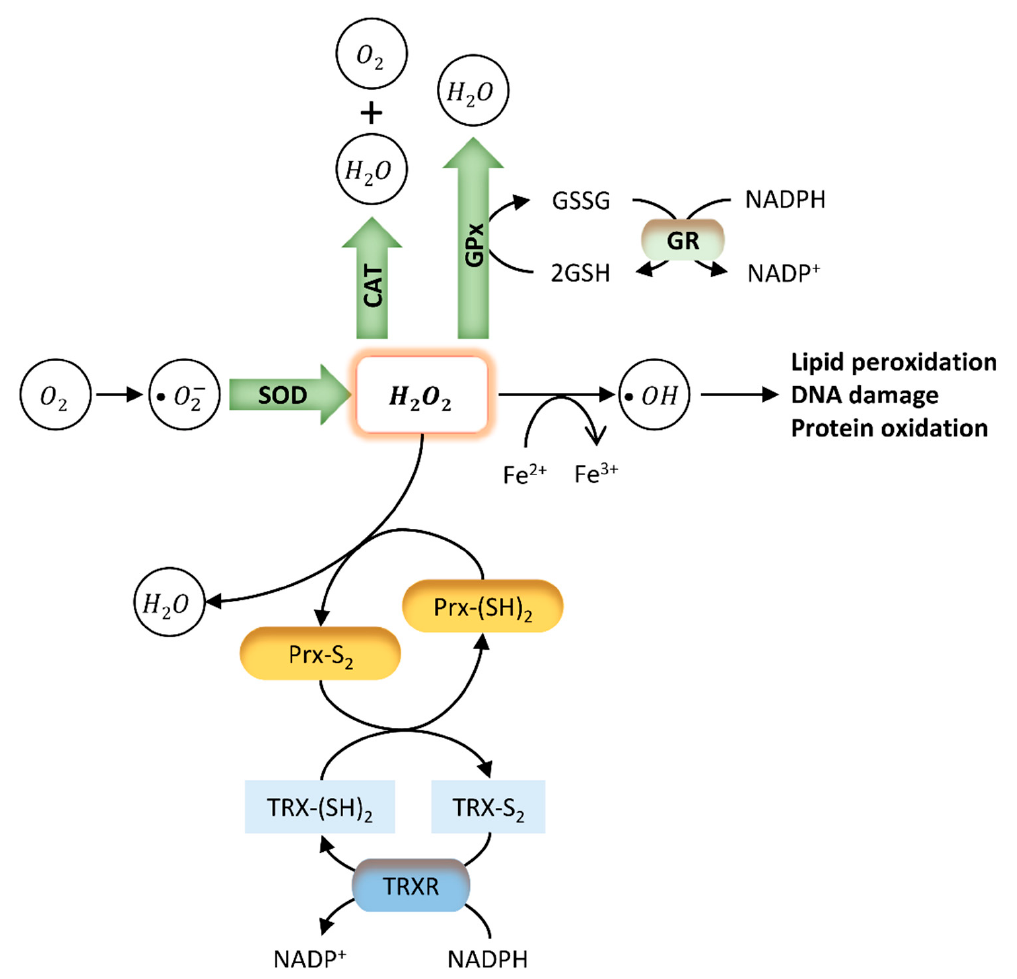
Figure 2. Endogenous antioxidant mechanisms. The oxidative stress (OS) caused by several external and internal factors leads to an excessive production of ROS intracellularly, including the free radicals hydroxyl (OH − ), peroxyl (HO 2 ), and superoxide (O 2 − ). Cellular redox homeostasis is maintained by an endogenous antioxidant defence system that includes the endogenous antioxidant enzymes SOD, CAT, GPx, and GSH (green). These antioxidants directly scavenge O 2 − and hydrogen peroxide (H 2 O 2 ), converting them into less reactive species. SOD catalyses the dismutation of superoxide radical to H 2 O 2 . H 2 O 2 is rapidly converted into OH - radical, which is very reactive and causes lipid peroxidation and DNA damage. GPx neutralizes H 2 O 2 by taking hydrogens from two GSH molecules resulting in two H 2 O and one GSSG. GR then regenerates GSH from GSSG. Finally, CAT neutralizes H 2 O 2 into H 2 O and O 2 . Two other antioxidant systems involve peroxiredoxins (Prx) (yellow) and the thioredoxin (TRX) system (blue). Prx are ubiquitous antioxidant enzymes that catalyse the reduction of H 2 O 2 , peroxynitrite (ONOO − ), and organic hydroperoxides to water, nitrite, or hydroxyl derivatives (ROH), respectively [118]. The TRX system composed by TRX, TRX reductase (TRXR), and NADPH is a ubiquitous thiol oxidoreductase system that also regulates cellular redox status [119]. Briefly, an initial oxidation of the active site of Prx forms an interchain disulphide (Prx-S2). The hyper-oxidation of Prx decreases localized peroxidase activity, leading to the oxidation of less sensitive proteins [118]. Reduced TRX (TRX-(SH)2) catalyses the reduction of disulphides (S-S) within oxidized proteins, including Prx - Prx-(SH)2. In this process, Trx becomes oxidized (TRX-S2), being further reduced by thioredoxin reductase (TRXR) at the expense of